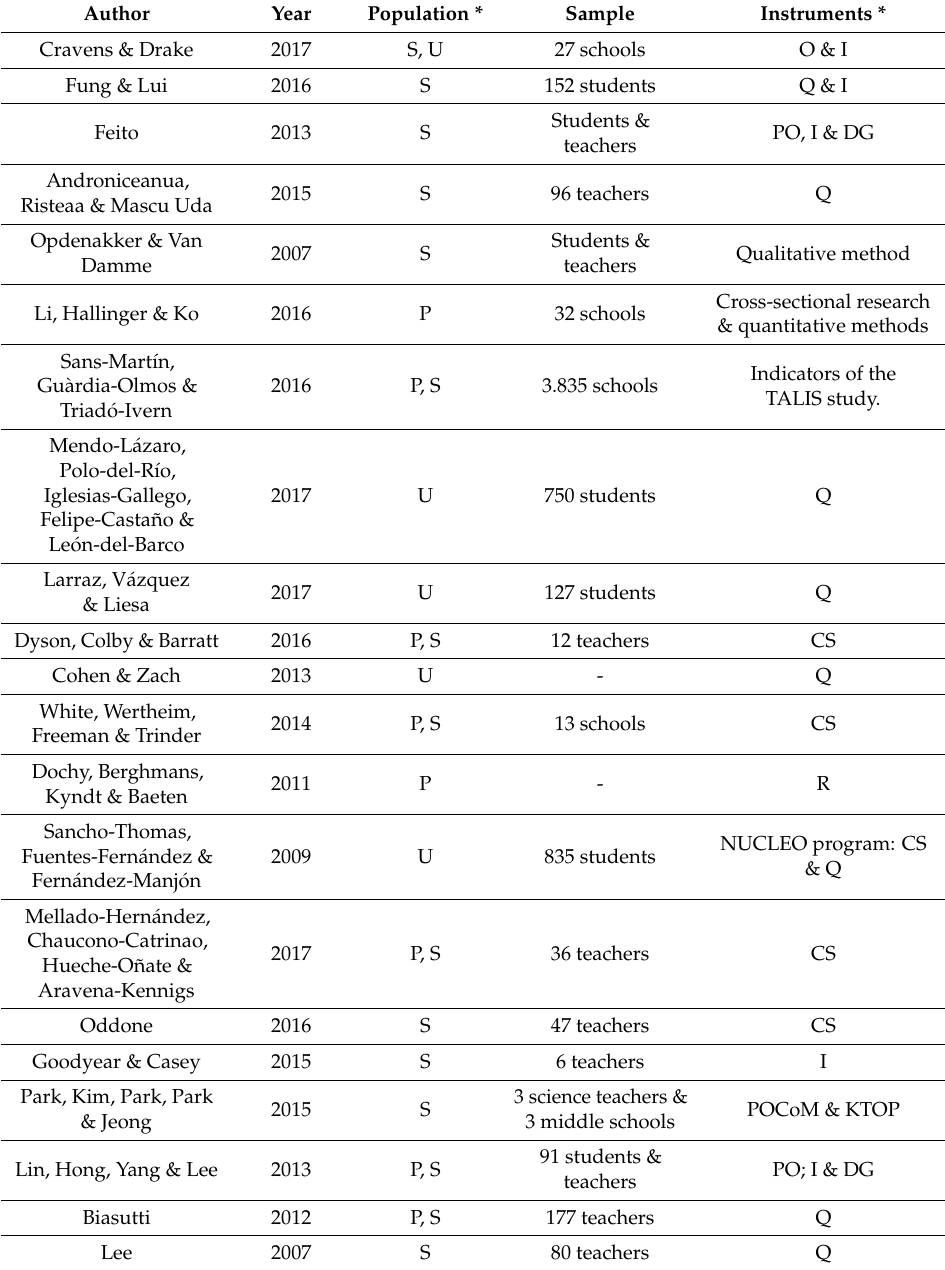
Table 2. List of articles that make up the systematic